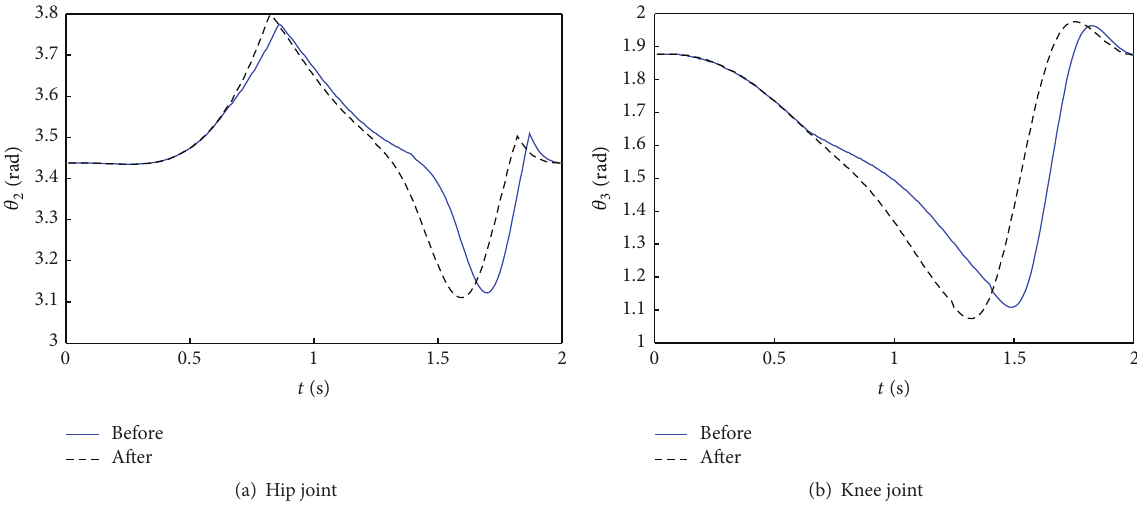
Figure 7: Variations of joint